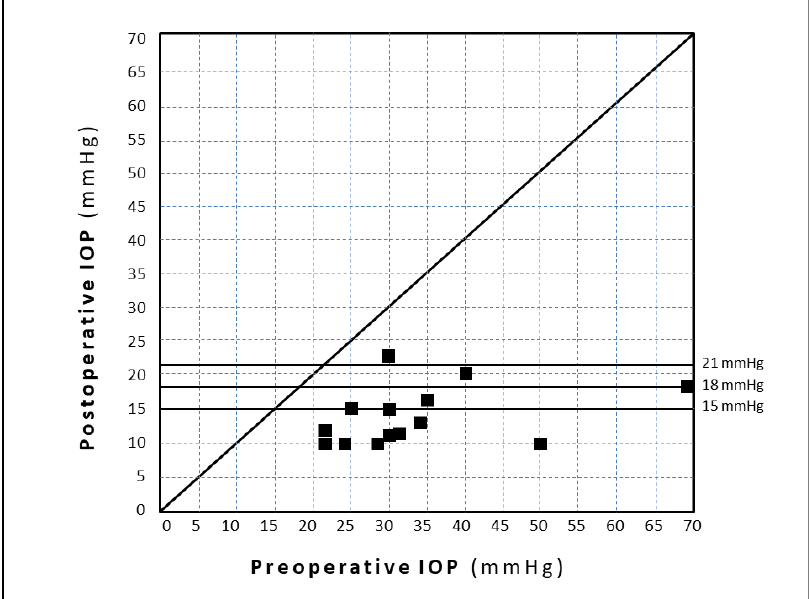
Figure 3. Scattergram showing the IOP values after three years vs. pre-operative IOP values. The Kaplan–Meier survival curve up to four years is shown in Figure 4.